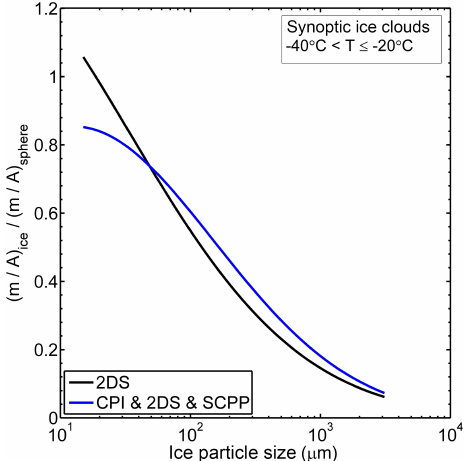
Figure 5. Dependence of ice particle projected area ( A) on D based on mean PSD within the indicated temperature regime. The CPI and 2D-S data have been grouped into size bins, and the black solid curve is a fit to these data sets (see Table 2 for equation).